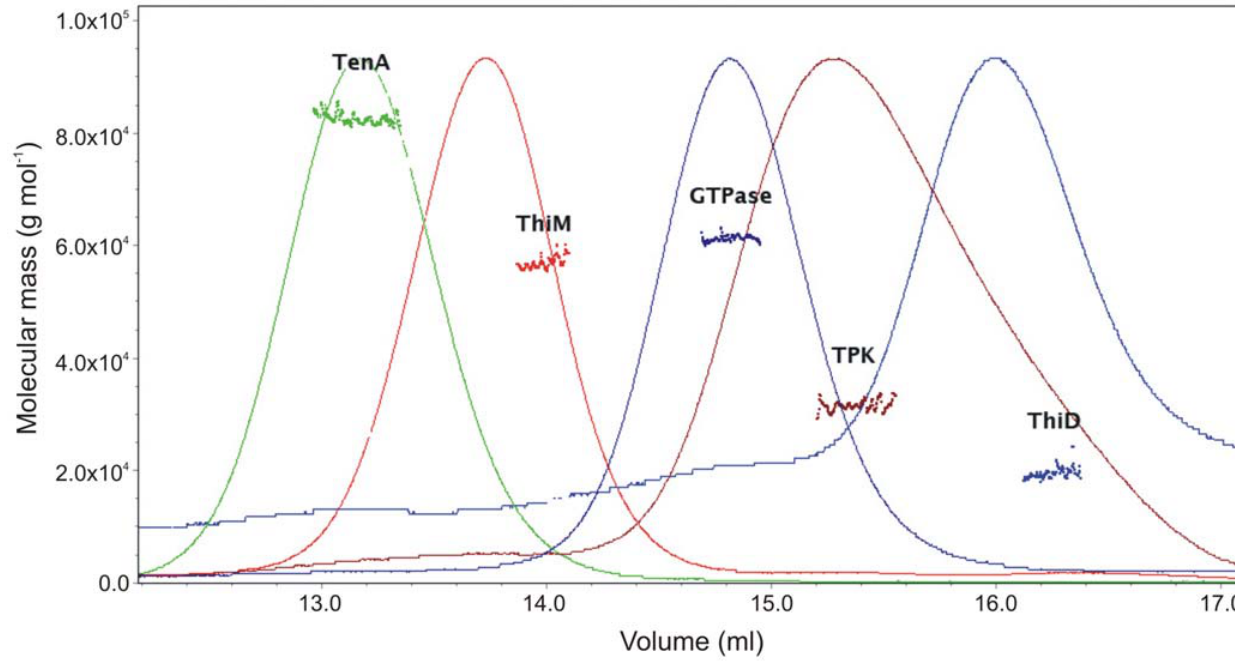
Figure 3. Static light scattering of the recombinant proteins. Size exclusion chromatography was performed with GTPase (purple); TPK (brown); TenA (green); ThiM (red); and ThiD (blue) and the masses measured by static light scattering. Molecular masses are given on the